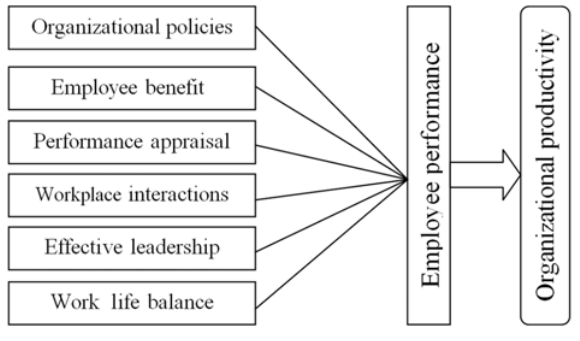
Fig. 1. Conceptual framework of the